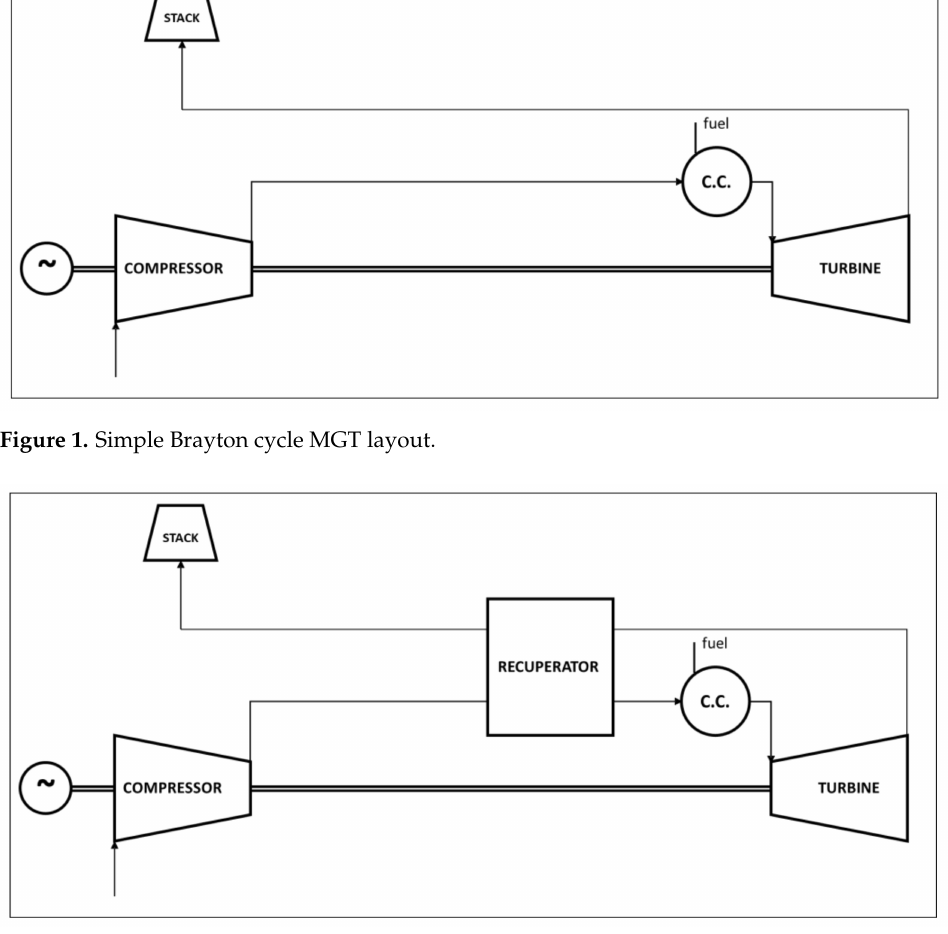
Figure 2. Recuperated